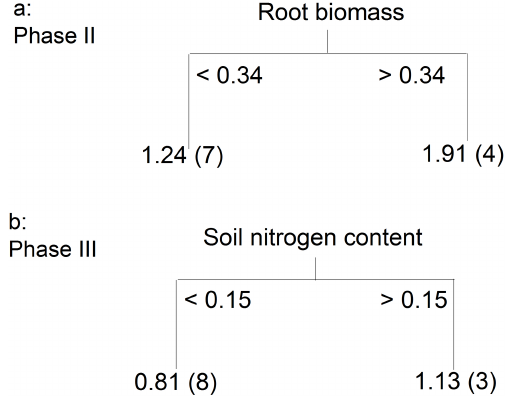
Figure 7. Results of CART analysis with key factors explaining spatial variability in soil respiration at the flower-bearing (a) and coloration–defoliation phases (b) . Predictor variables are depicted at the top of each branch. Their critical values are shown at the side of each branch and the mean soil CO 2 efflux (including number of observations in parentheses) is reported below the terminal